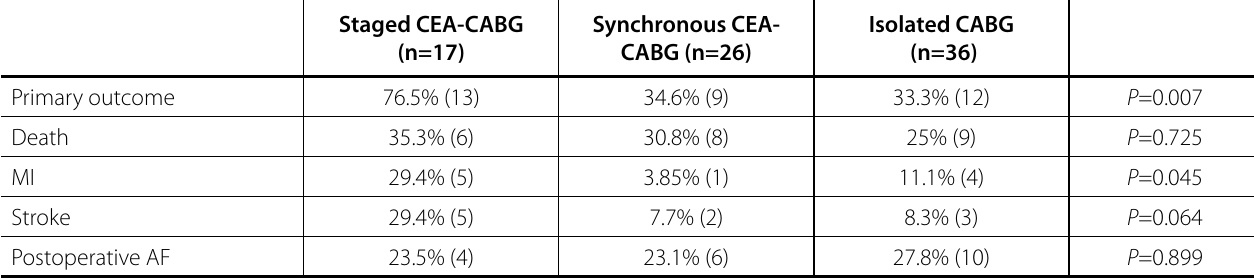
Table 2 . Clinical